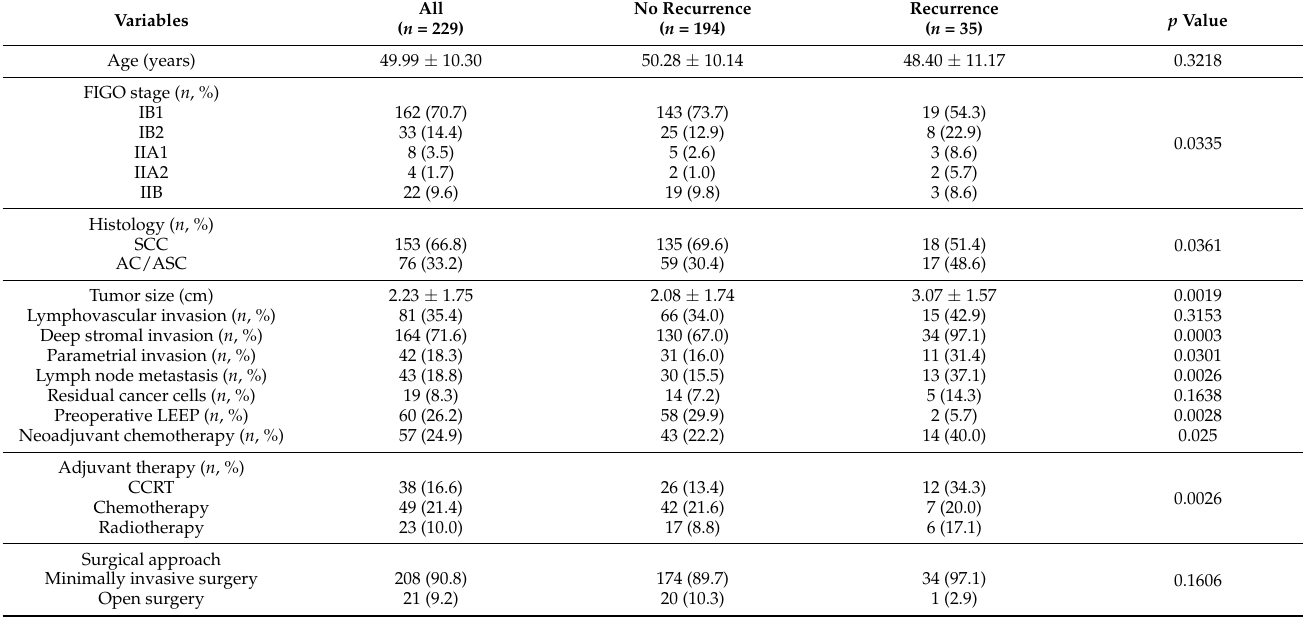
Table 1. Clinicopathologic characteristics of cervical cancer patients with and without